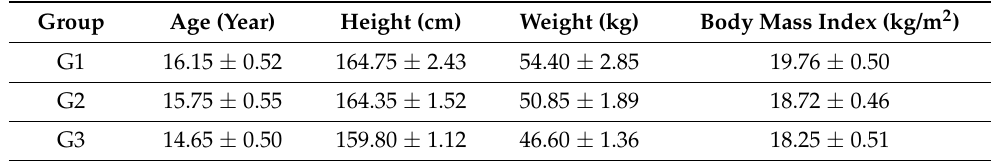
Table 1. Participants’ physical characteristics.